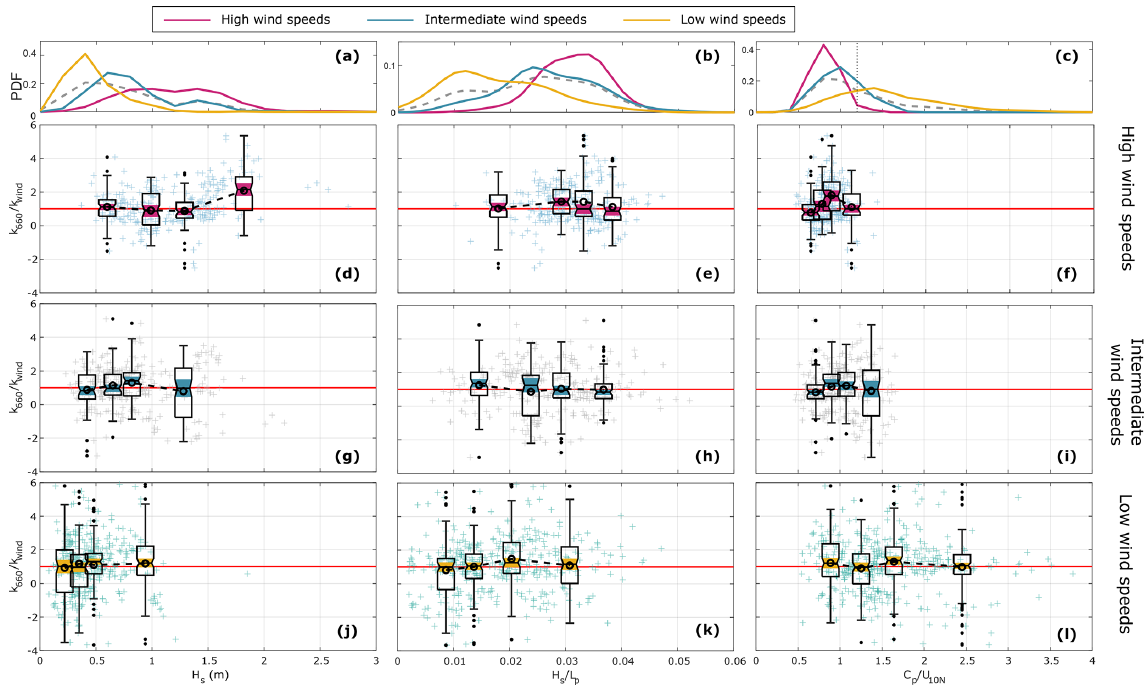
Figure A2. Same as in Fig. A1 for wave field characteristics: significant wave height (left), wave steepness (centre), and wave age (right).